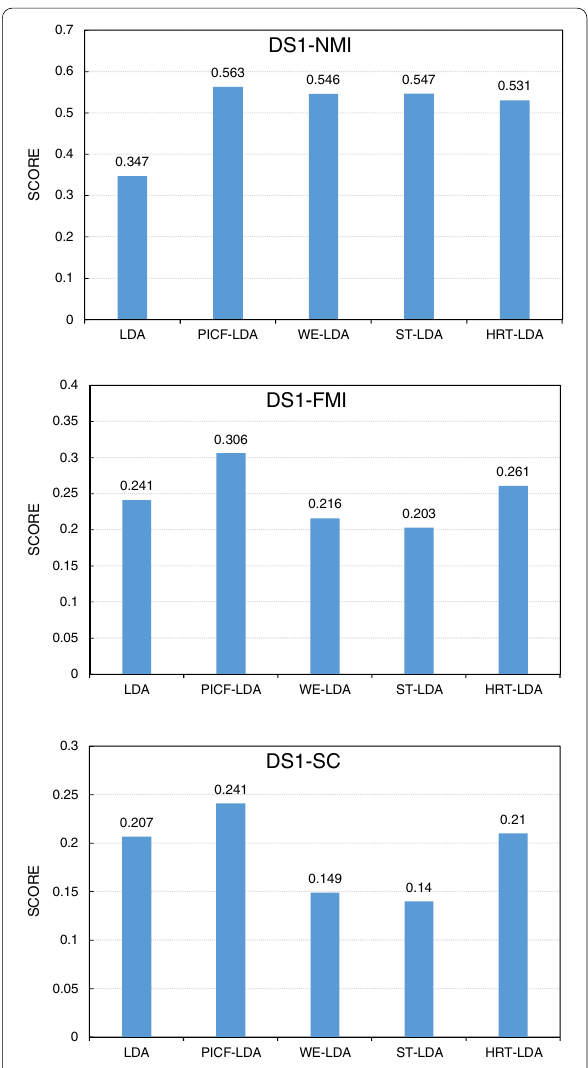
Fig. 5 Performance comparison between PICF-LDA and variant LDA models in DS1